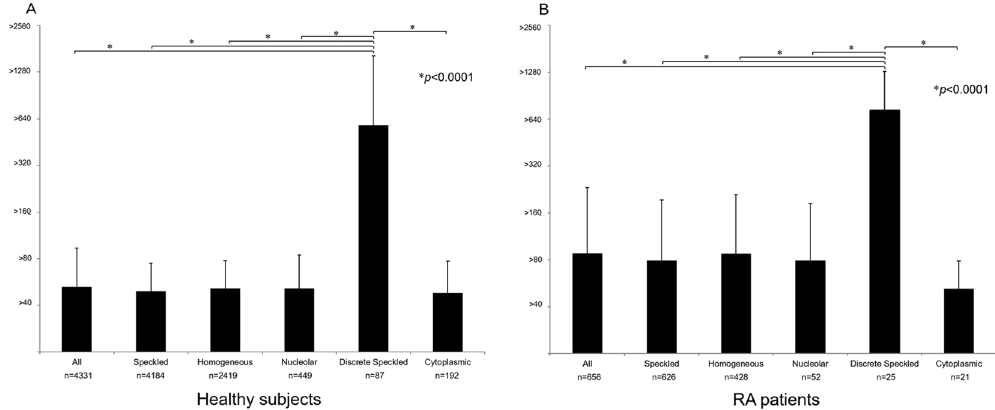
Figure 1. Distribution of ANA levels by each staining pattern. The ANA levels were log-transformed (log 2 (level/40) + 1) and compared by Wilcoxon rank sum test. ACA showed a significantly higher level than the other staining patterns in ( A ) healthy subjects, and ( B ) RA patients in the KURAMA cohort (p < 0.0001). Most subjects were positive for multiple ANA staining patterns.